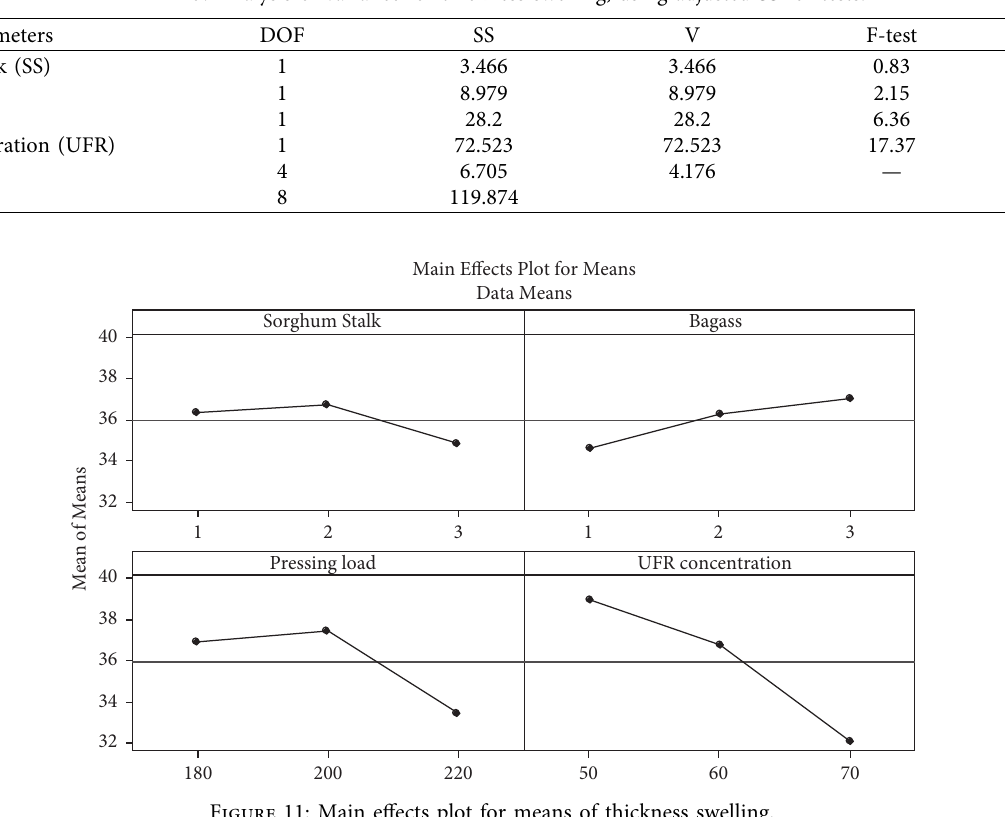
Table 15: Analysis of variance for thickness swelling, using adjusted SS for tests.